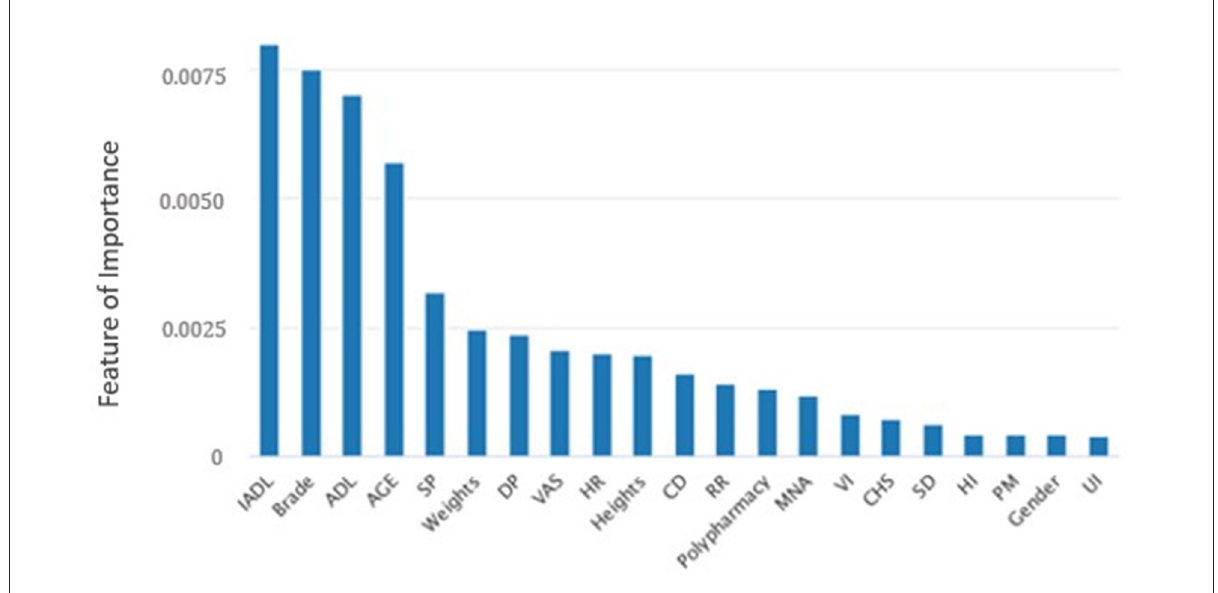
FIGURE1 Feature of importance of all 21 features in XGBoost model. IADL, Instrumental activity of daily living; ADL, Activity of daily living; SP, Systolic pressure; DP, Diastolic pressure; VAS, Visual analog scale; HR, Heart rate; CD, Communication disturbance; RR, Respiratory rate; MNA, Mini nutritional assessment; VI, Visual impairment; CHS, Cardiovascular health study; SD, Sleep disturbance; HI, Hearing impairment; PM, Psychiatric medication; UI, Urinary